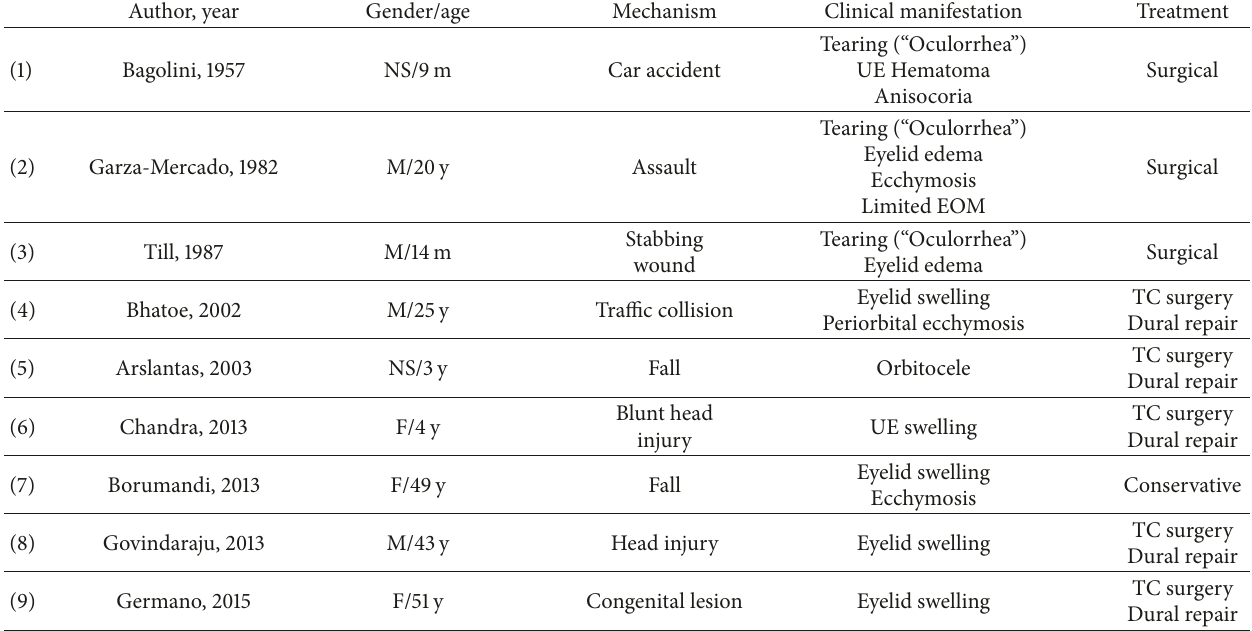
Table 1: Literature review of blepharocele case reports.